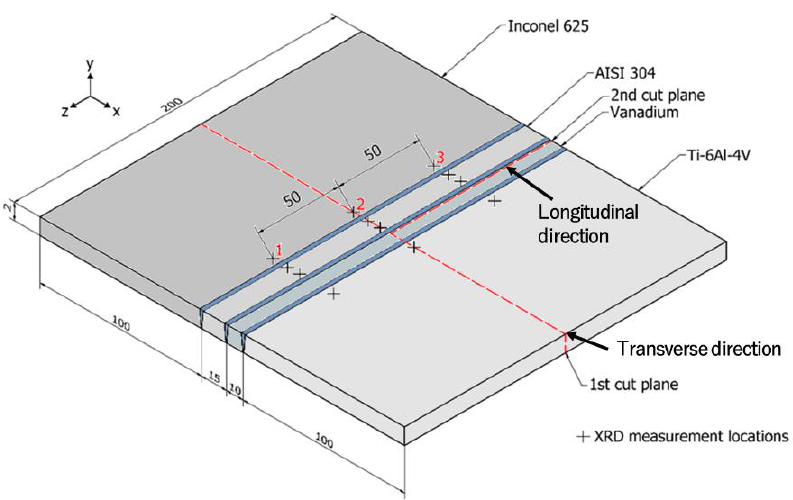
Figure 2. Schematic illustration of the welded plates. XRD measurement locations are indicated by crosses, while the two cuts used for the contour method are displayed by dotted lines. All dimensions are in